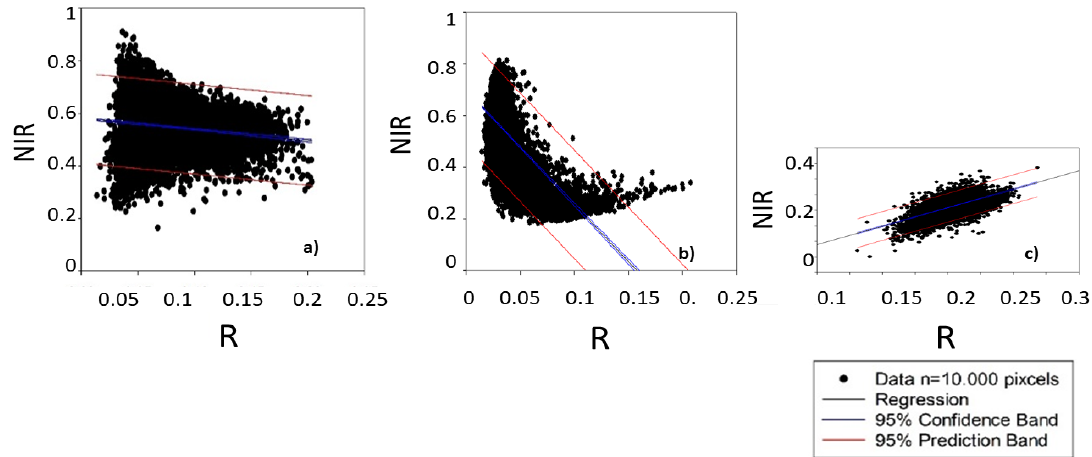
Figure 6. Polynomial linear correlations of NIR–R reflectance at 10,000 random points on the study site according to land use. ( a ) pasture study site, ( b ) potatoes study site, ( c ) bare soil study site. Source: Results of the current research